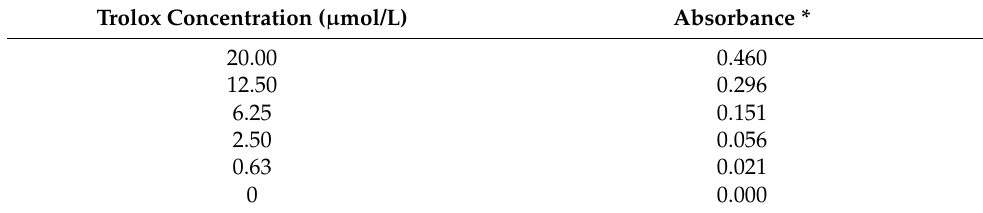
Table A4. Calibration curve for antioxidant activity